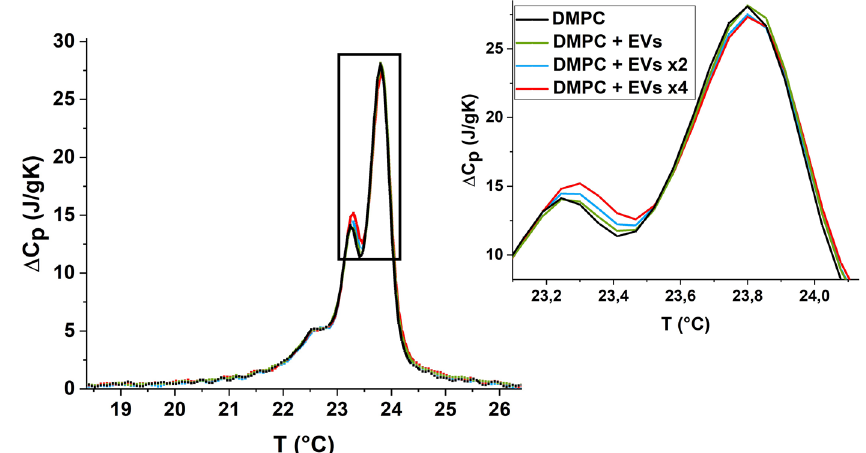
Figure 2: Trend of Δ C p ( T ) of DMPC LUVs after addition of increasing amounts of